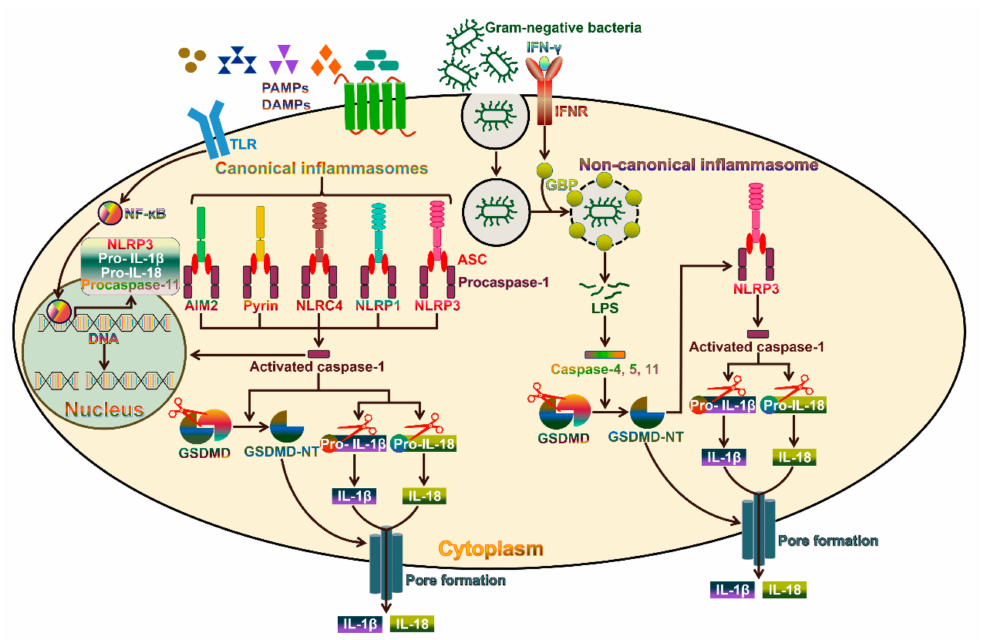
Figure 1. Molecular mechanisms involved in inflammasome activation. Activation of the canonical